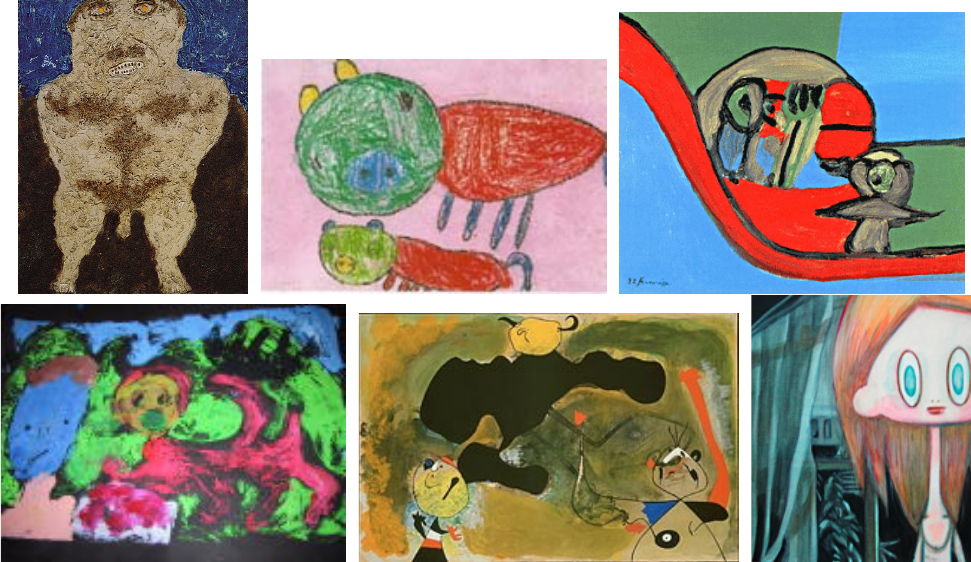
Figure 1. Several paintings (downloaded from various sites more than 10 years ago.